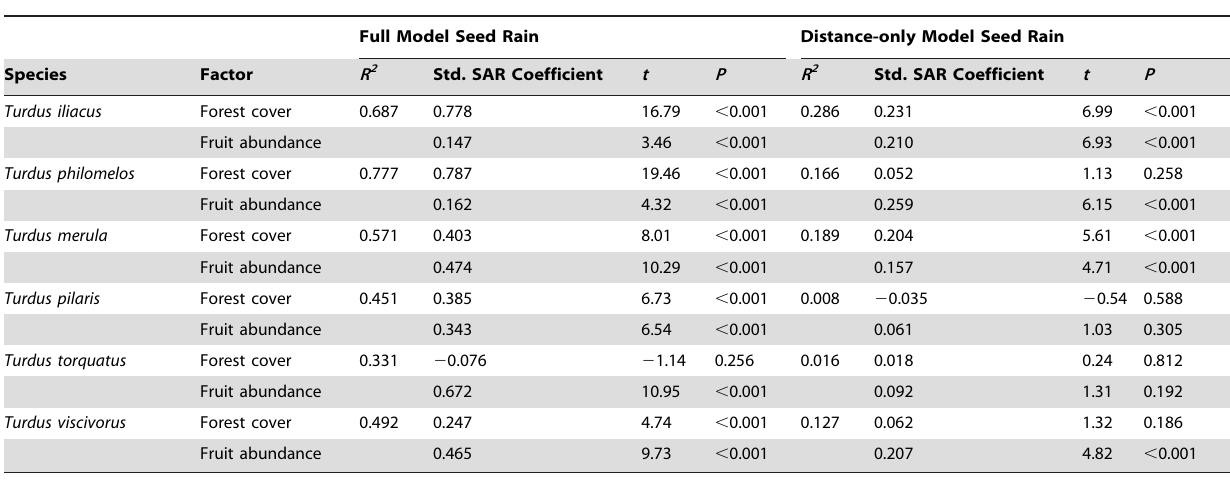
Table 1. Spatial Simultaneous Autoregressive Models (SAR) evaluating the relative effect of forest cover (arcsin sqrt proportion per cell) and fruit abundance (log number fruits per cell) in the proportion of seed dispersed per cell (from the total number of seed dispersed, arcsin sqrt) for the different species of frugivorous